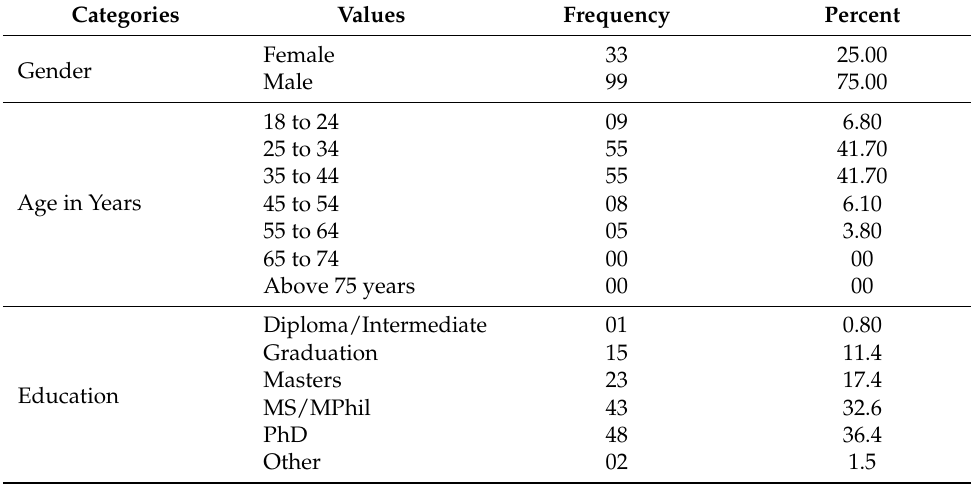
Table 2. Demographics of the respondents.